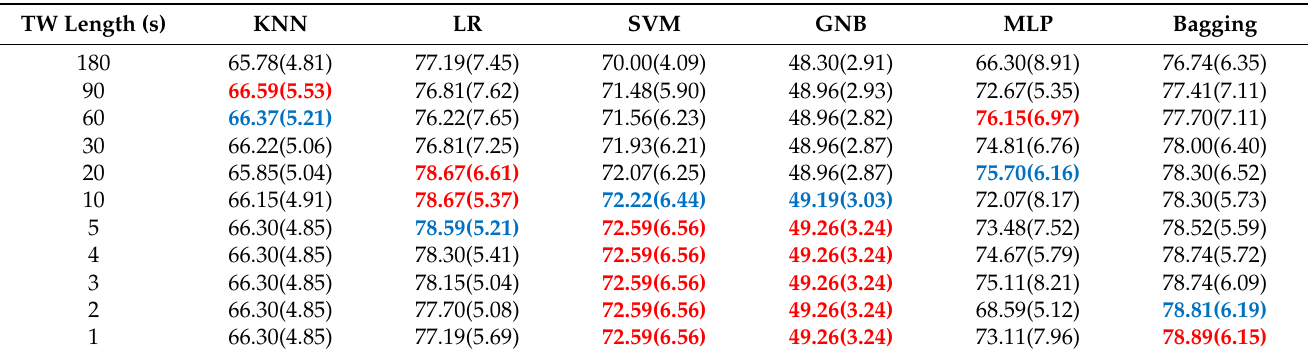
Table 6. The recognition results (mean accuracy and standard deviation) of DE features extracted from separate frequency bands when using different classifiers under different TW lengths without ELBN. The highest and second-highest accuracies of each classifier are highlighted in bold red and bold blue,